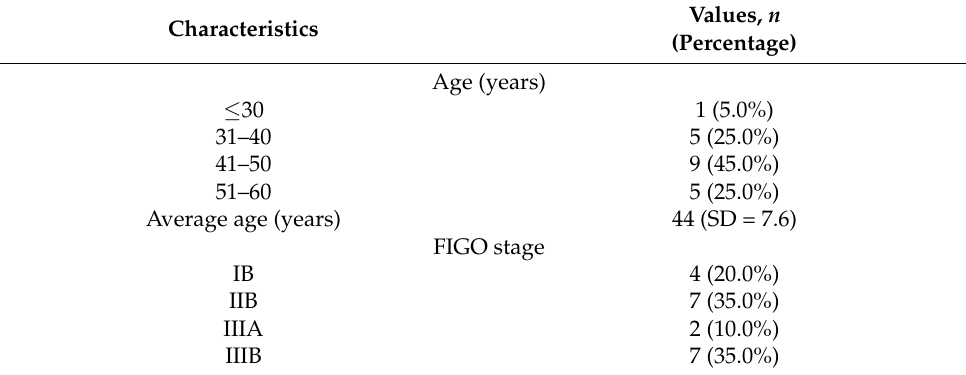
FIGO—International Federation of Gynecology and